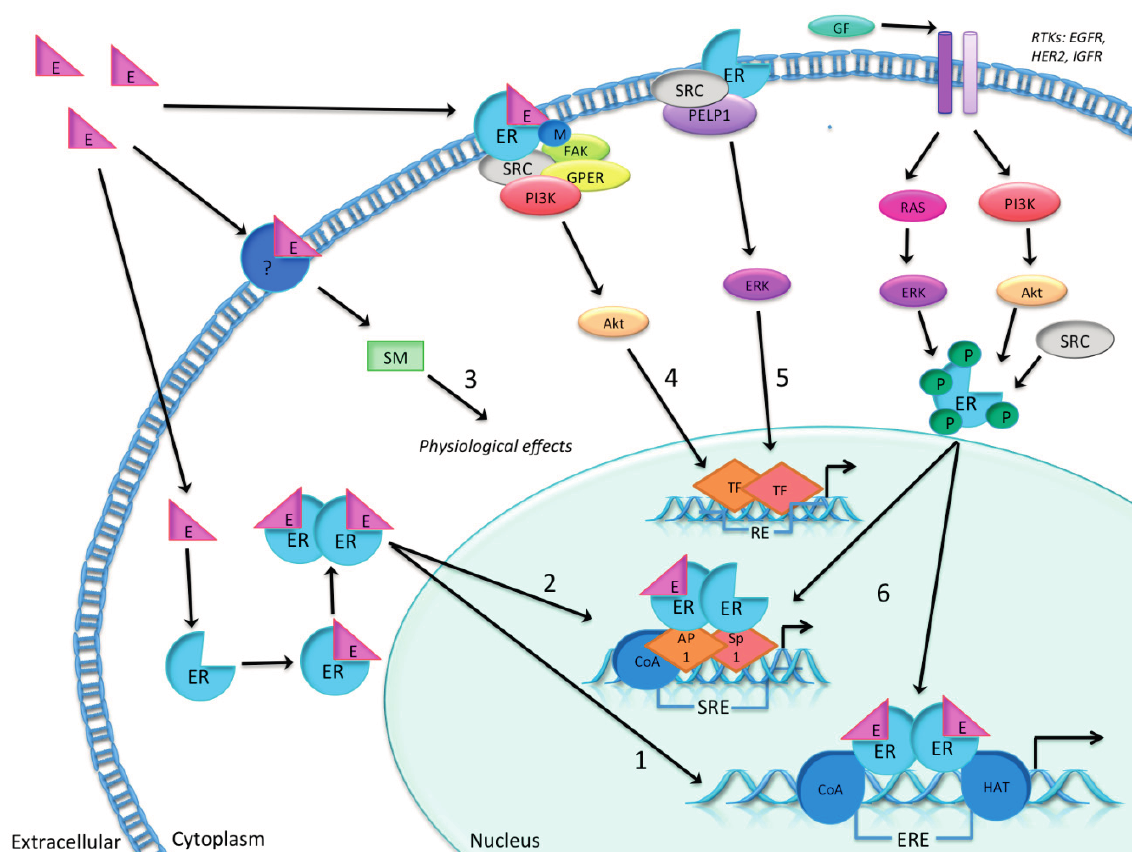
Figure 1. Simplified possible molecular signaling pathways ( 1 to 6 ) of estrogen (E) and estrogen receptors (ER). ( 1 ) Classical and direct pathway: ligand activation is followed by binding to the estrogen response element (ERE), including coactivators (CoA) and histone acetyl transferases (HATs) before gene regulation is modified; ( 2 ) tethered pathway: ligand dependent pathway which includes protein-protein interaction with other transcription factors, e.g., activator protein 1 (Ap1) and specificity protein 1 (Sp1), after ligand activation, thereby regulating genes by indirect DNA binding following serum response element (SRE) activation of transcription; ( 3 ) non-genomic ligand dependent reaction: the receptor (e.g., classical ER, ER isoform or other receptors) is activated by a ligand, which may be associated with the membrane. This is then followed by signaling cascades initiated by second messengers (SM), initiating a rapid physiological response, which does not involve gene regulation; ( 4 ) ligand-dependent reaction: ER is methylated by ligand induction and ER–phosphoinositide 3-kinase (PI3K)–steroid receptor coactivator (SRC)-focal adhesion kinase (FAK) forms a complex that further activates the serine/threonine–protein kinase Akt, which then activates transcription without ER binding to DNA; ( 5 ) ligand independent reaction: ER–SRC–proline-, glutamic acid and leucine-rich protein 1 (PELP1) forms a complex which then activates transcription, also without ER binding to DNA; ( 6 ) another ligand independent reaction activates through other signaling pathways, like growth factor signaling by downstream events of receptor tyrosine kinase (RTKs), such as epidermal growth factor receptor (EGFR), human epidermal growth factor receptor 2 (HER2) and the insulin-like growth factor receptor (IGFR) [11,23]